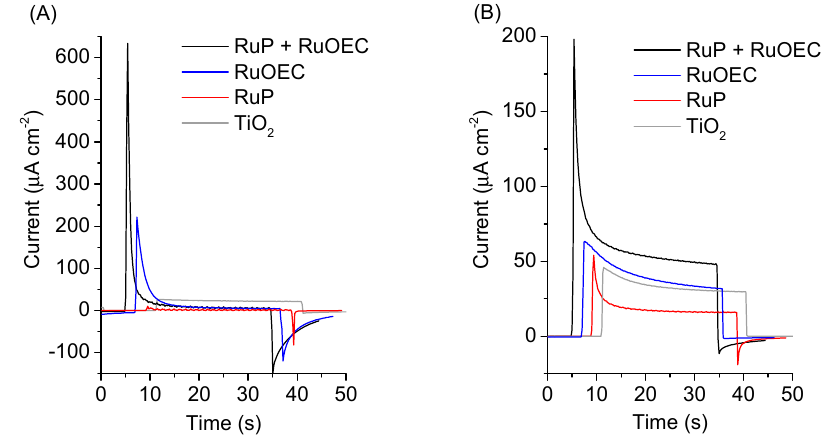
J 0 : Initial photocurrent; J stab : Steady-state photocurrent; J dark : Dark photocurrent. The electrode area is taken as the geometric area.